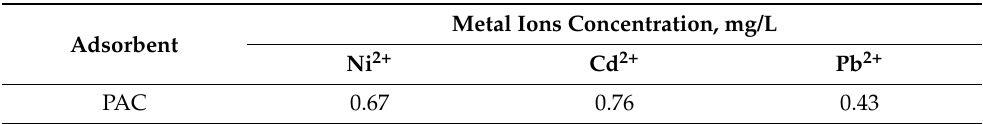
Table 7. Metal ions concentration in modified water after adsorption on PAC (dose 100 mg/L), time of shaking 60 min, initial concentration of heavy metal ions 1.0 mg/L.